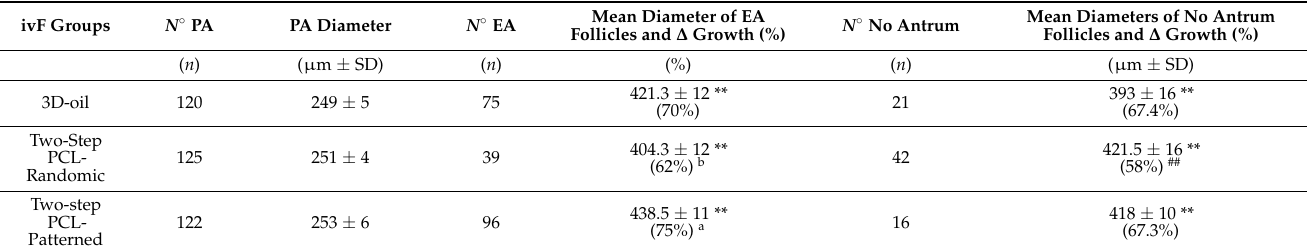
Table 1. PCL-electrospun scaffold influence on ivF outcomes: quantitative and qualitative aspects according to follicular experimental